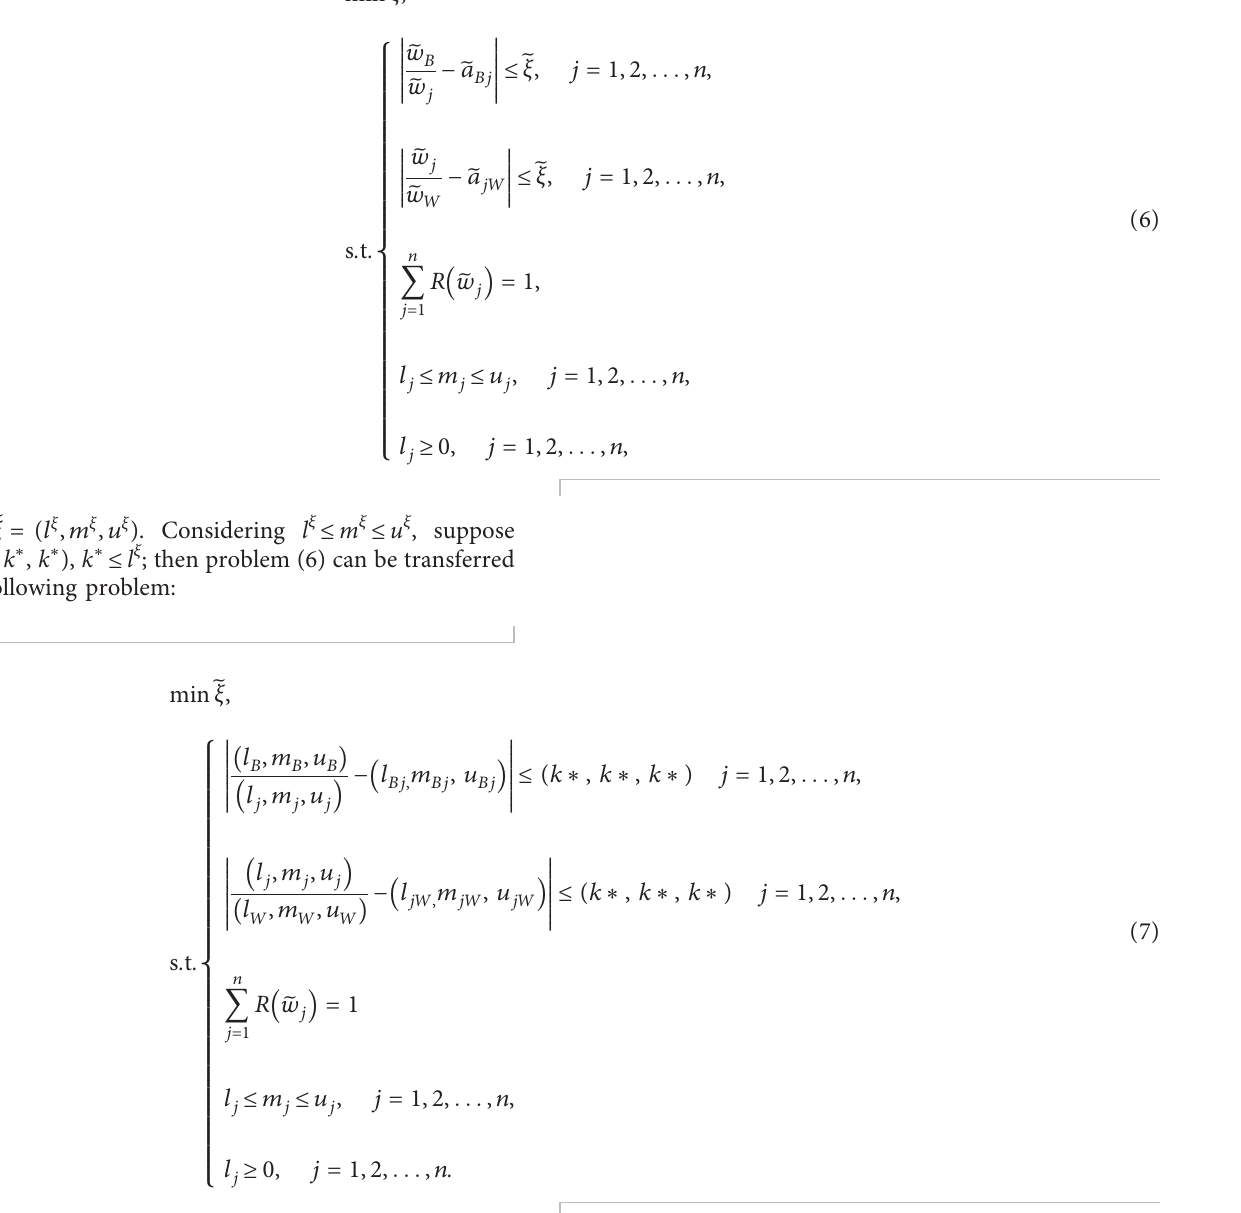
Consistency ratio (CR) is then calculated as follows: CR values closer to zero show high